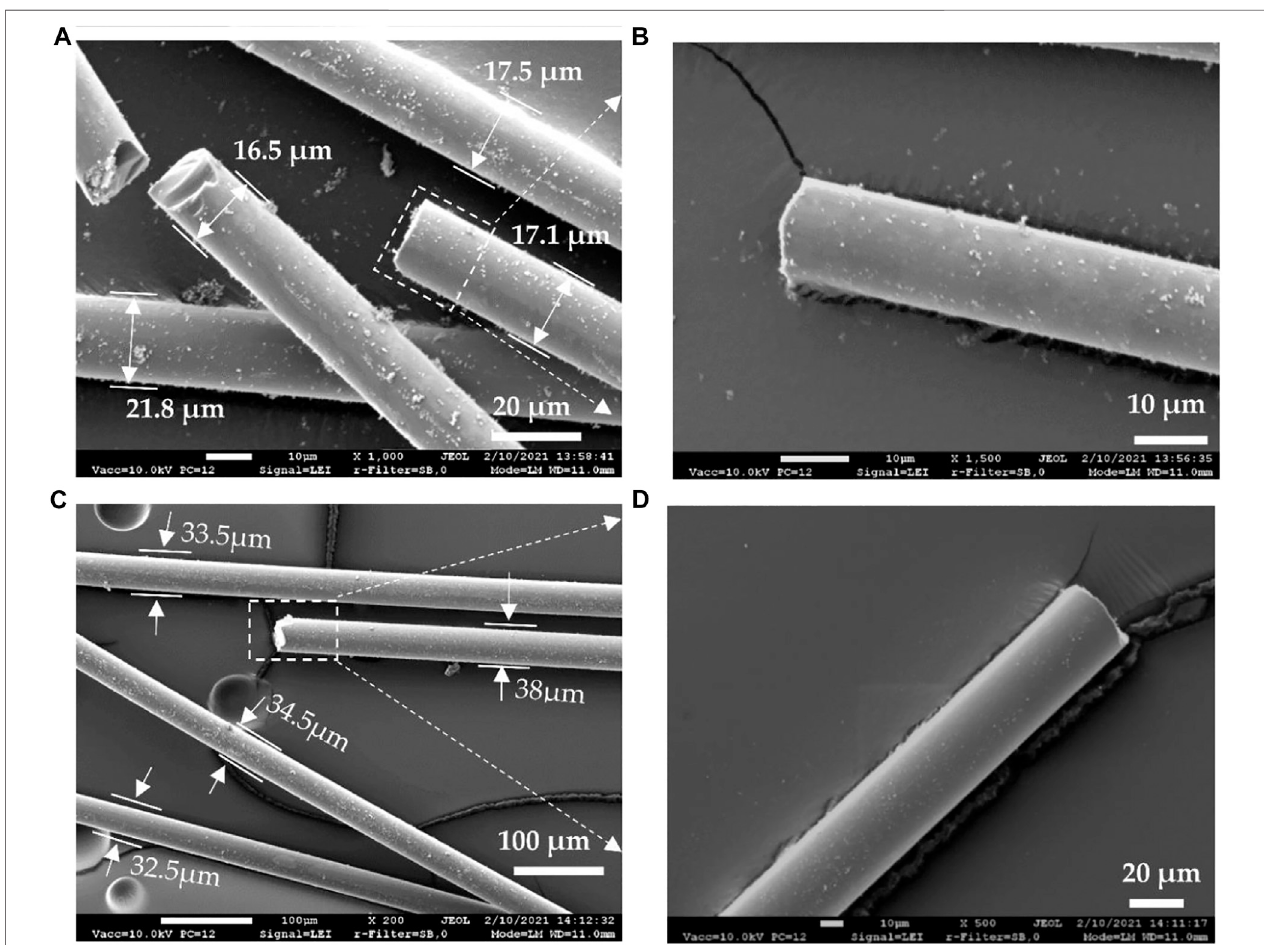
FIGURE 4 | SEM images of separate fi bers: (A , B) F IBERLINE pro fi le; (C , D) U GIRA sample. Note: the rectangles localize the zoomed view place of the images (B , D) .